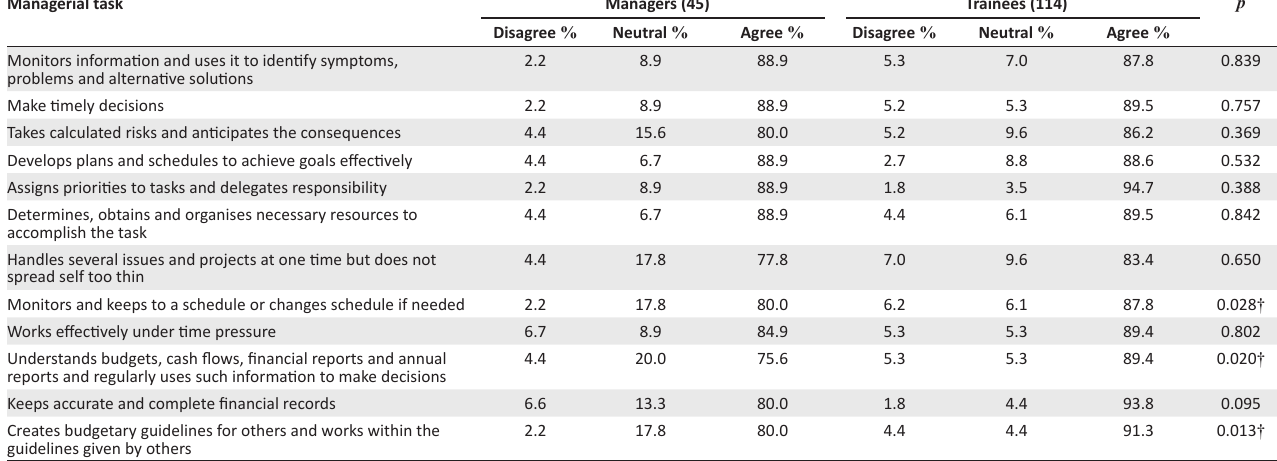
TABLE 5: Results for planning and administration. Managerial